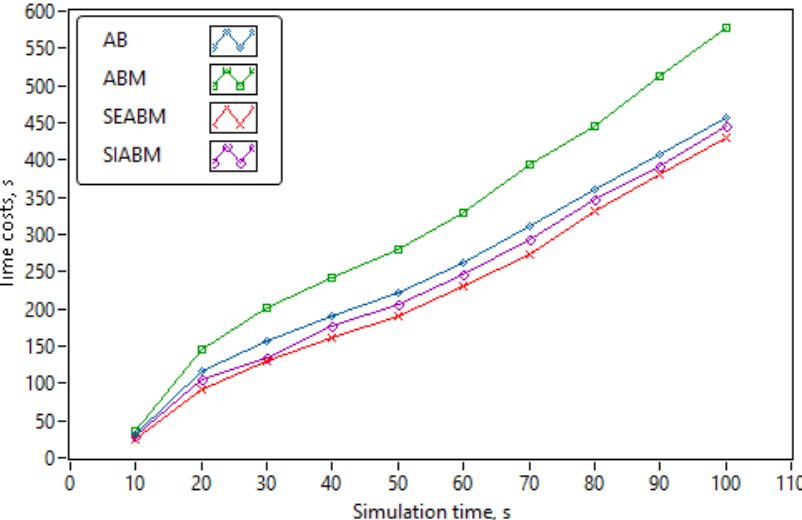
Figure 10. Simulation time costs dependence on the simulation time. Fixed integration step case, h = 0.01.